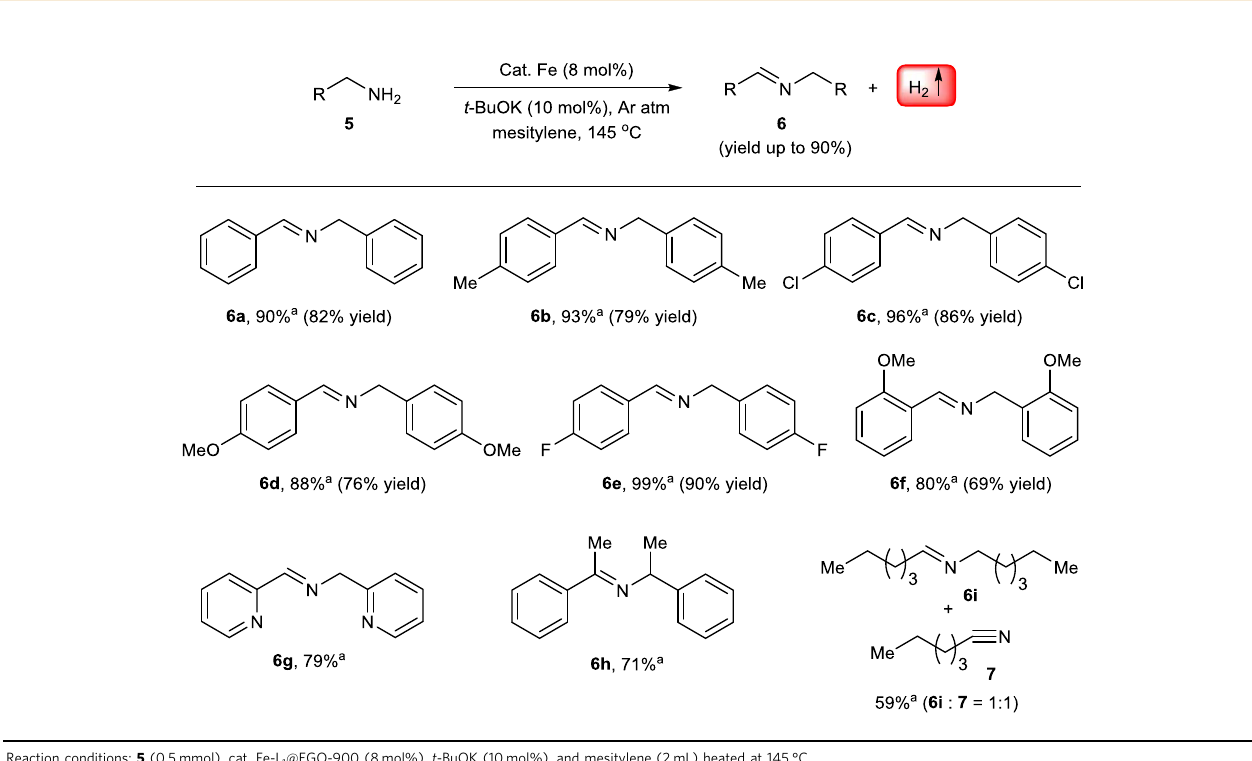
Table 3 Iron-catalyzed dehydrogenation of amines to imines with extraction of H